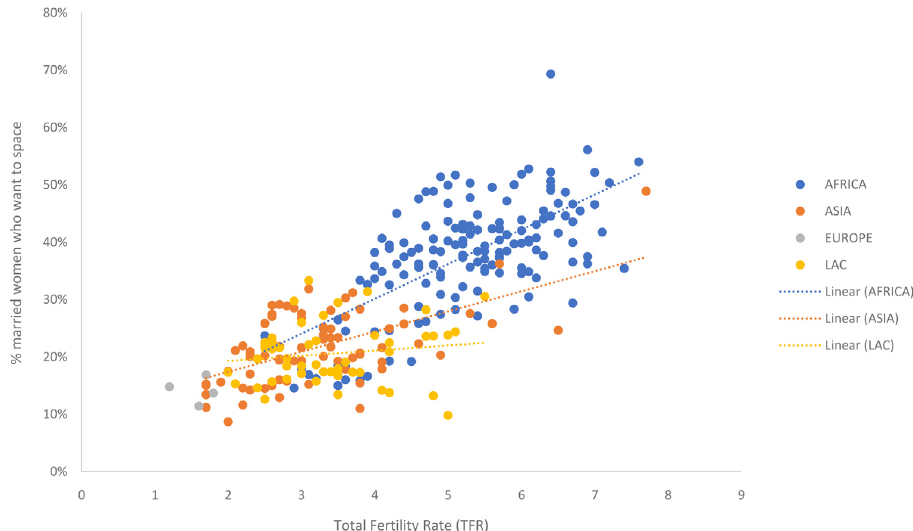
Figure 1. Relationship between TFR and share of married women who want to space their next birth. The dots in the scatterplot represent survey data from all available Demographic and Health Surveys (DHS), color coded by region. The data shows the relationship between the total fertility rate (TFR) and the share of married women who want to space their next